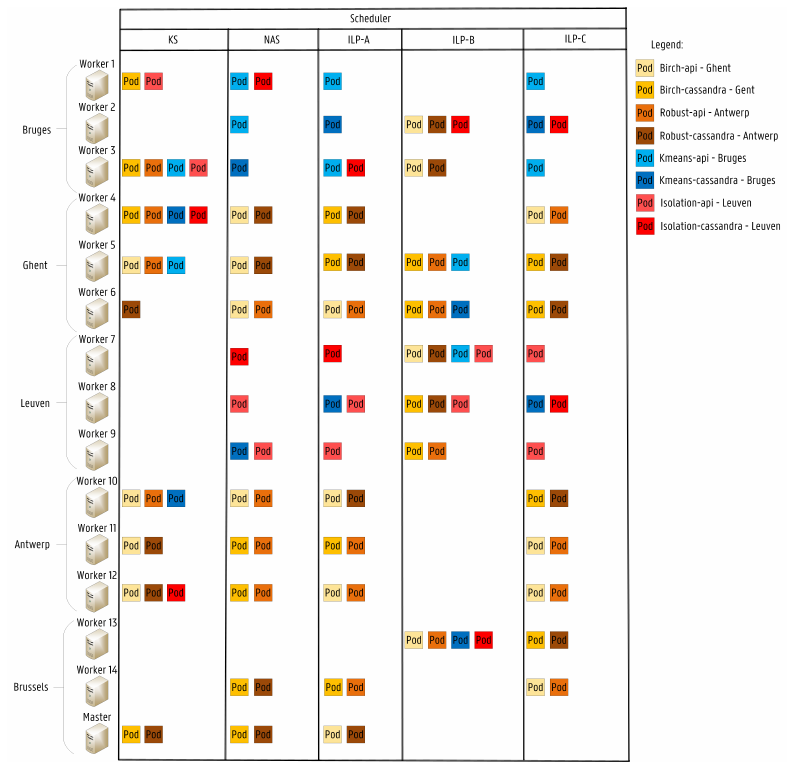
Figure 11. The service provisioning schemes of the different